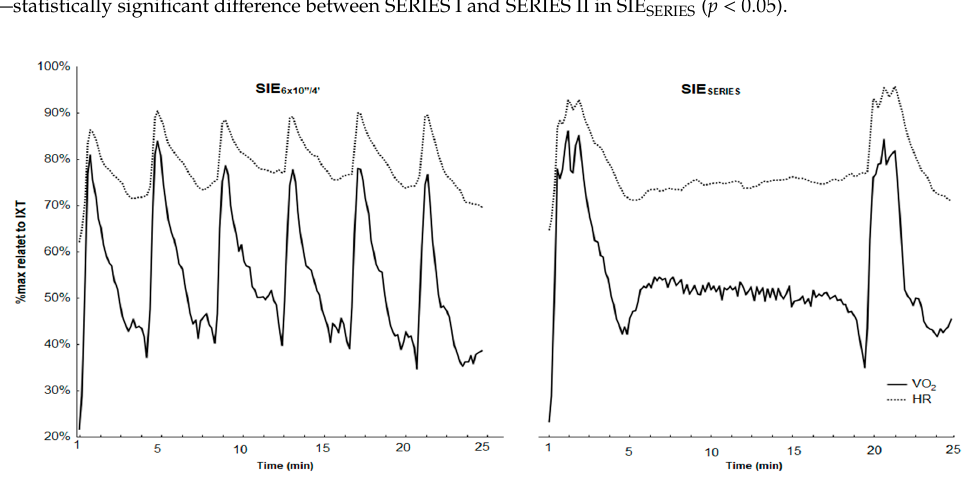
Table 3. Comparison of physiological and perceptual responses between both SIE protocols.